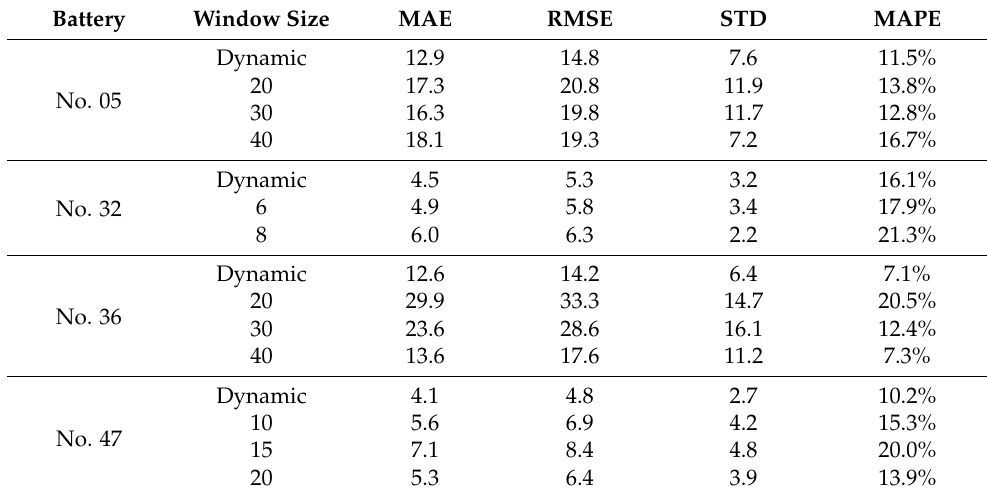
Table 2. Prediction results of four types of batteries under different experimental